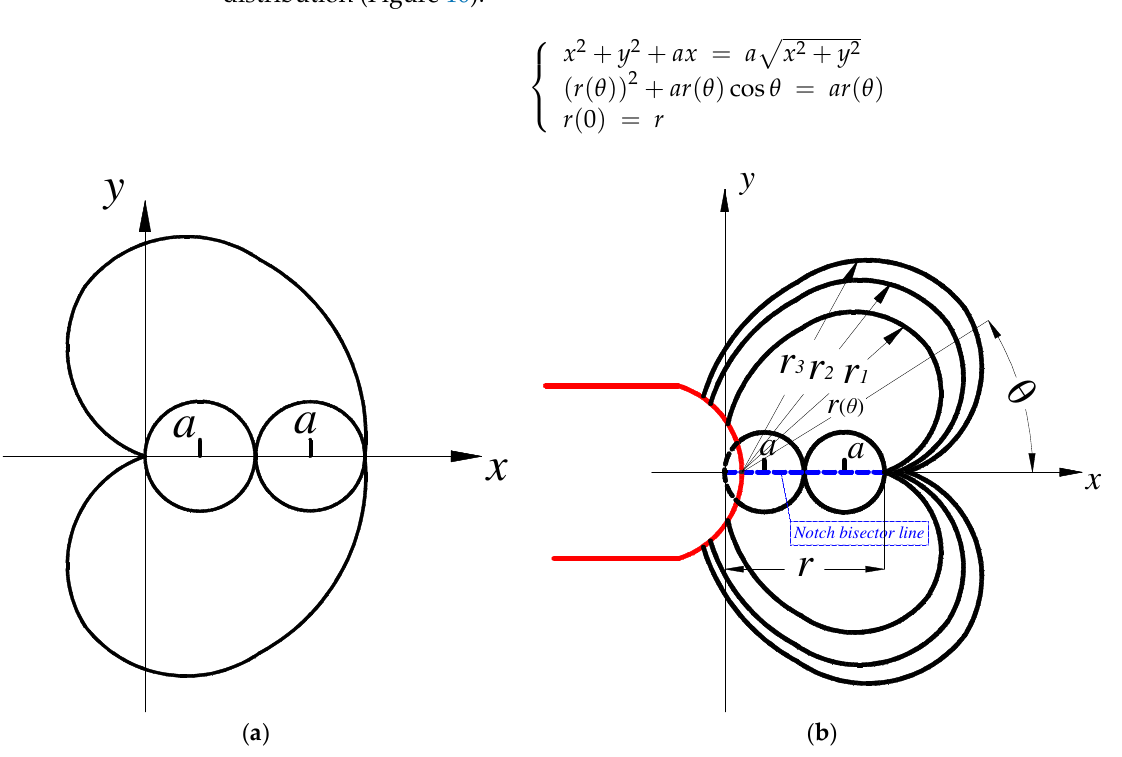
Figure 10. Schematic representation of the U-notched specimen. ( a ) Cartesian cardioid. ( b ) Relation- ship between stress contours and the peak point.